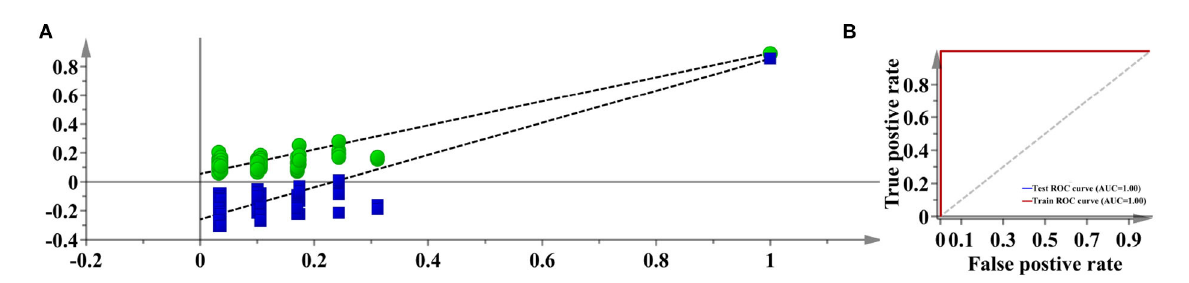
FIGURE9 The permutation and AUC plots of the developed PLS-DA model (Description: (A) represents the permutation plot; (B) represents the AUC plot. According to the visualization result, PLS-DA confidently exports a 100% accuracy for discriminating between Danshen and Non-Danshen medicines. We show the AUC and permutation plots to indicate the reliability of this model.).